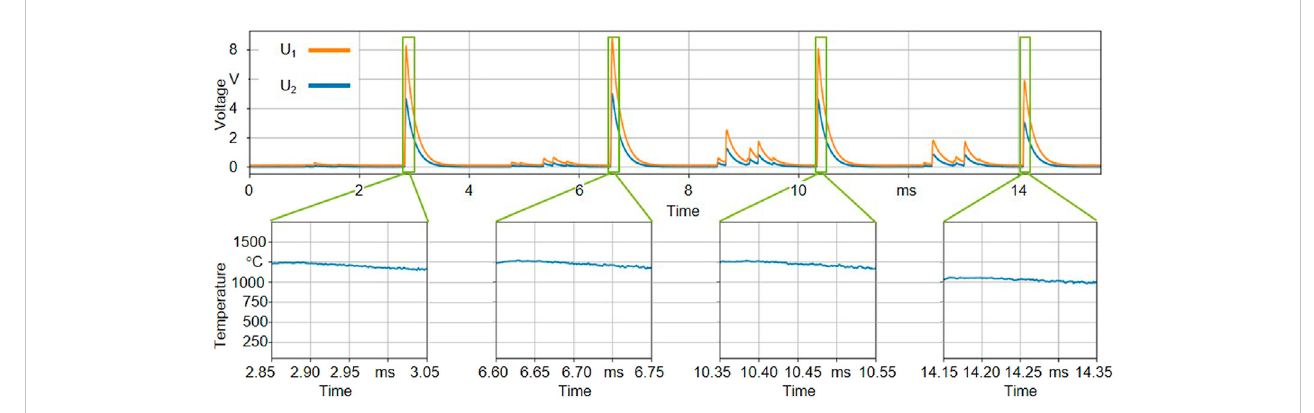
FIGURE 10 Exemplary result of a single grain temperature measurement from a grinding